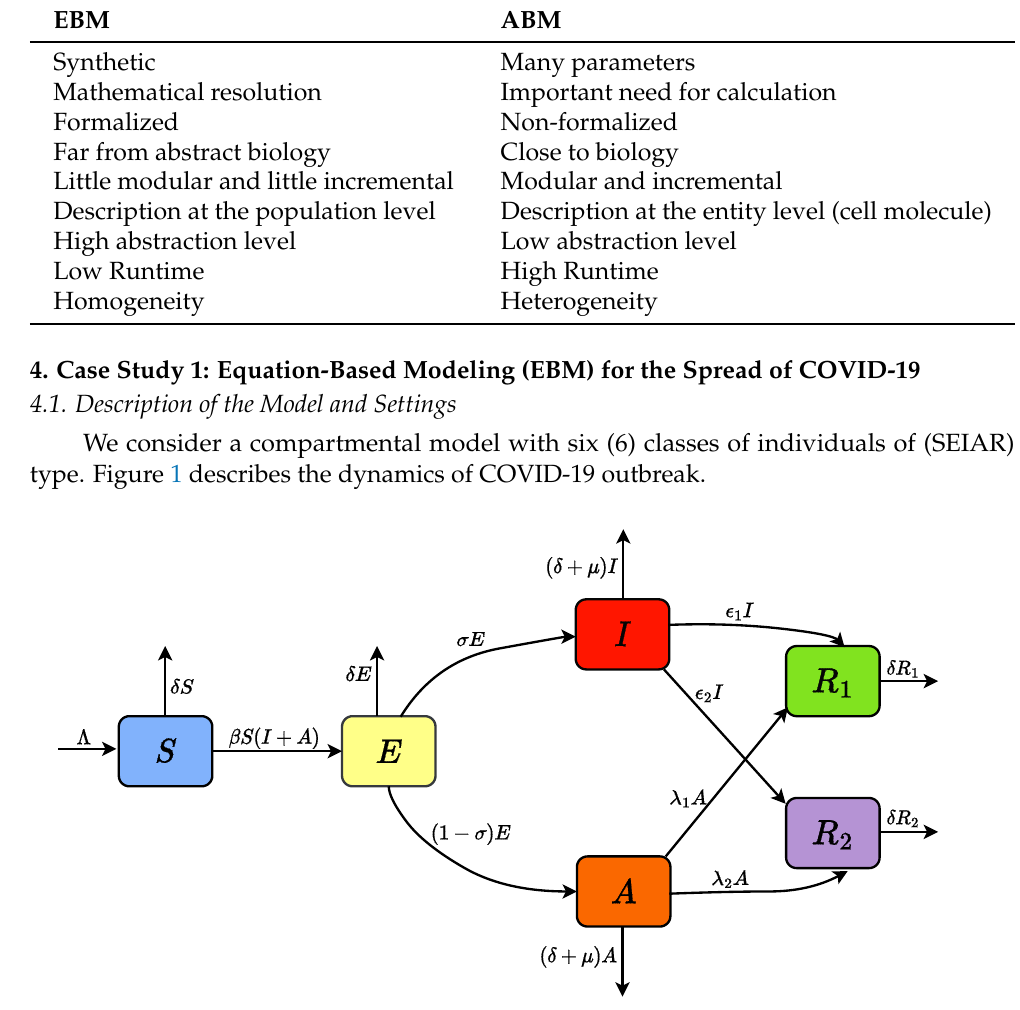
Table 1. Brief comparison table of equation-based modeling and and agent-based modeling.